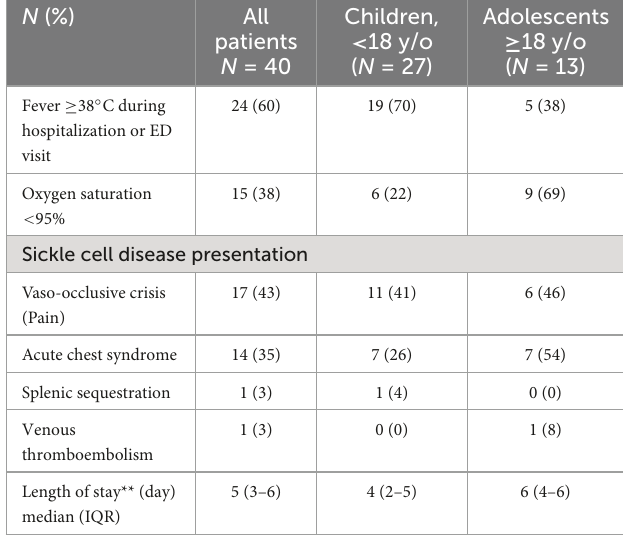
TABLE 2 Clinical presentation and characteristics of hospitalized and ED